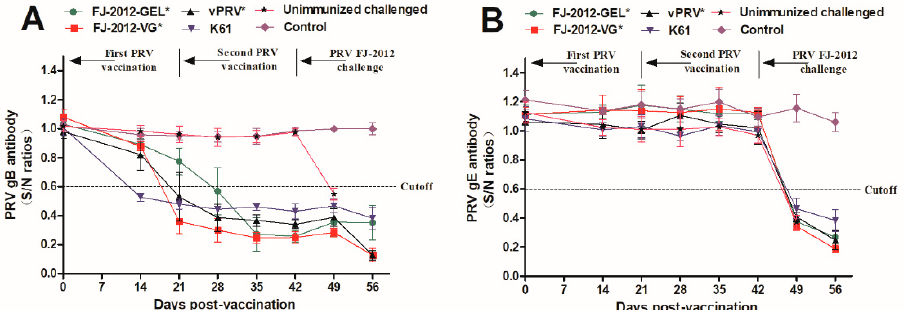
Figure 1. Development of anti-gB ( A ) and gE ( B ) antibodies with ELISA. ( A ) gB-specific antibody levels: a sample with S/N ratios ≤ 0.60 were classified as positive for gB antibodies. ( B ) gE-specific antibody levels: a sample with S/N ratios ≤ 0.60 were classified as positive for gE antibodies. The “*” mark in the group top right indicates an inactivated vaccine.